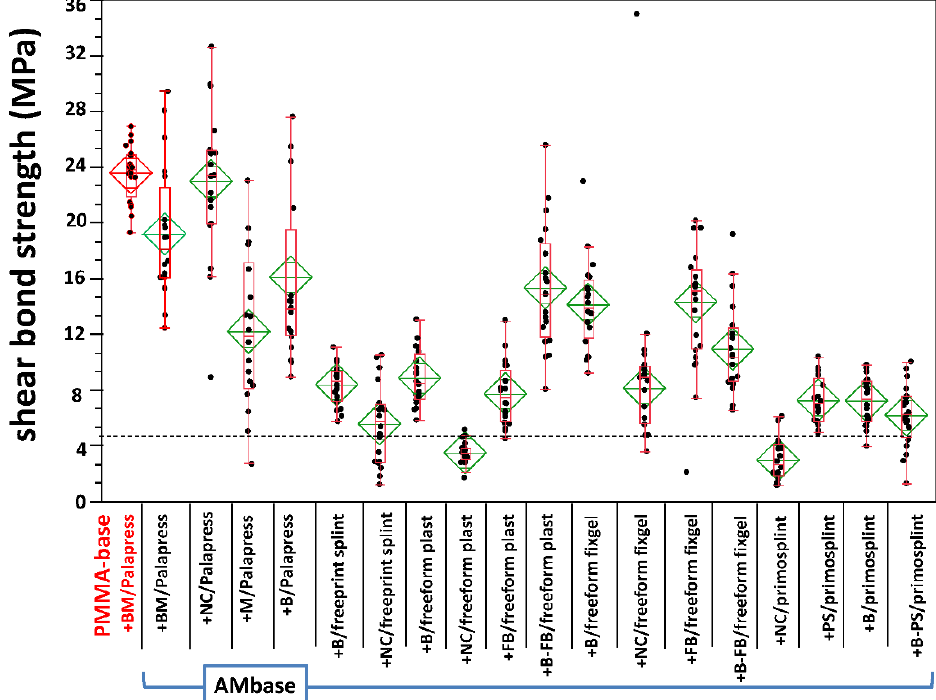
Figure 8. Boxplot of the shear bond strength values within the experimental groups after wet storage. The gold standard (PMMA) is plotted on the left (marked red). The boxplots with median values are supported by mean diamonds with 95% confidence intervals. The dashed horizontal line gives the threshold of 5 MPa defined by the standard (ISO 10477).